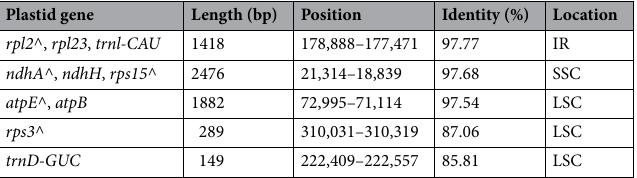
Table 3. Plastid gene insertions in the mitochondrial genome of Mesta. ^Partial.